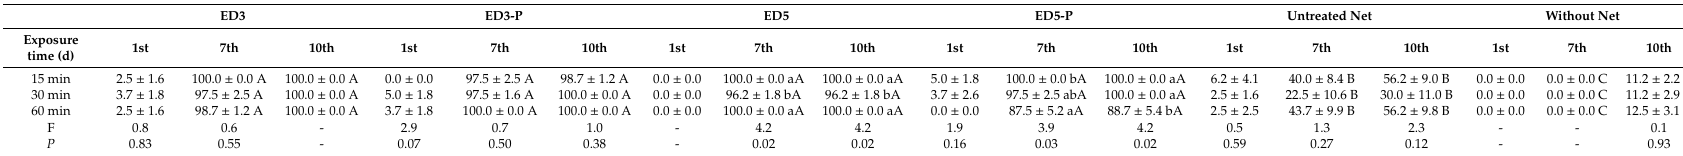
- - 52.1 - - 10.5 - - - 1.0 2.2 - 0.1 3.2 P < 0.01 - - < 0.01 - - < 0.01 - - < 0.01 - - - 0.38 0.13 - 0.86 0.06 Within each exposure interval, post-exposure interval, and net formulation, means followed by the same lowercase letters (a, b) do not di ff er significantly according to Tukey-Kramer HSD test at P < 0.05. Within each exposure interval, post-exposure interval, and net formulation, mortality, and knockdown means followed by the same uppercase letters (A, B) do not di ff er significantly across treatments according to Tukey-Kramer HSD test at P < 0.05. Where no letter exist, no significant di ff erences were noted. ANOVA parameters for long-term e ff ect and knocked down adults were: at 15 min F = 22.8, P < 0.01, 30 min, F = 2.9, P = 0.02, 60 min, F = 12.4, P < 0.01, whereas for short-term e ff ect and knocked down adults at 60 min, F = 22.9, P < 0.01. For delayed mortality at 15 min, F = 54.3, P < 0.01, 30 min, F = 779.5, P < 0.01, 60 min, F = 88.7, P < 0.01, in all cases df = 2, 23. In the case where “-“is indicated, F and P values were not provided in the Table since no variances among the samples were recorded. Table 4. Delayed mortality (% ± SE) of Sitophilus oryzae adults exposed for 15, 30, and 60 min to dishes with four di ff erent nets (ED3, ED3-P, ED5, ED5-P), dishes with untreated net and dishes without net. The 1st, 7th and 10th day after exposure for each exposure interval is considered as the long-term e ff ect. ED3 ED3-P ED5 ED5-P UntreatedNet WithoutNet Exposure time(d) 1st 7th 7th 10th 1st 7th 10th 1st 7th 10th 15min - 0.93 Within each exposure interval, post-exposure interval, and net formulation, means followed by the same lowercase letters (a, b) do not di ff er significantly according to the Tukey-Kramer HSD test at P < 0.05. Within each exposure interval, post-exposure interval, and net formulation, mortality means followed by the same uppercase letters (A, B) do not di ff er significantly across treatments according to the Tukey-Kramer HSD test at P < 0.05. Where no letters exist, no significant di ff erences were noted. ANOVA parameters for 1st day were: at 15 min, F = 1.9, P = 0.10, 30 min, F = 1.6, P = 0.18, 60 min, F = 1.3, P = 0.26, for 7th day were: at 15 min, F = 142.2, P < 0.01, 30 min, F = 91.9, P < 0.01, 60 min, F = 79.1, P < 0.01, whereas for 10th day were: at 15 min, F = 92.2, P < 0.01, 30 min, F = 75.4, P < 0.01, 60 min, F = 55.6, P < 0.01, in all cases df = 5, 47. In the case where “-“is indicated, F and P values were not provided in the Table since no variances among the samples were